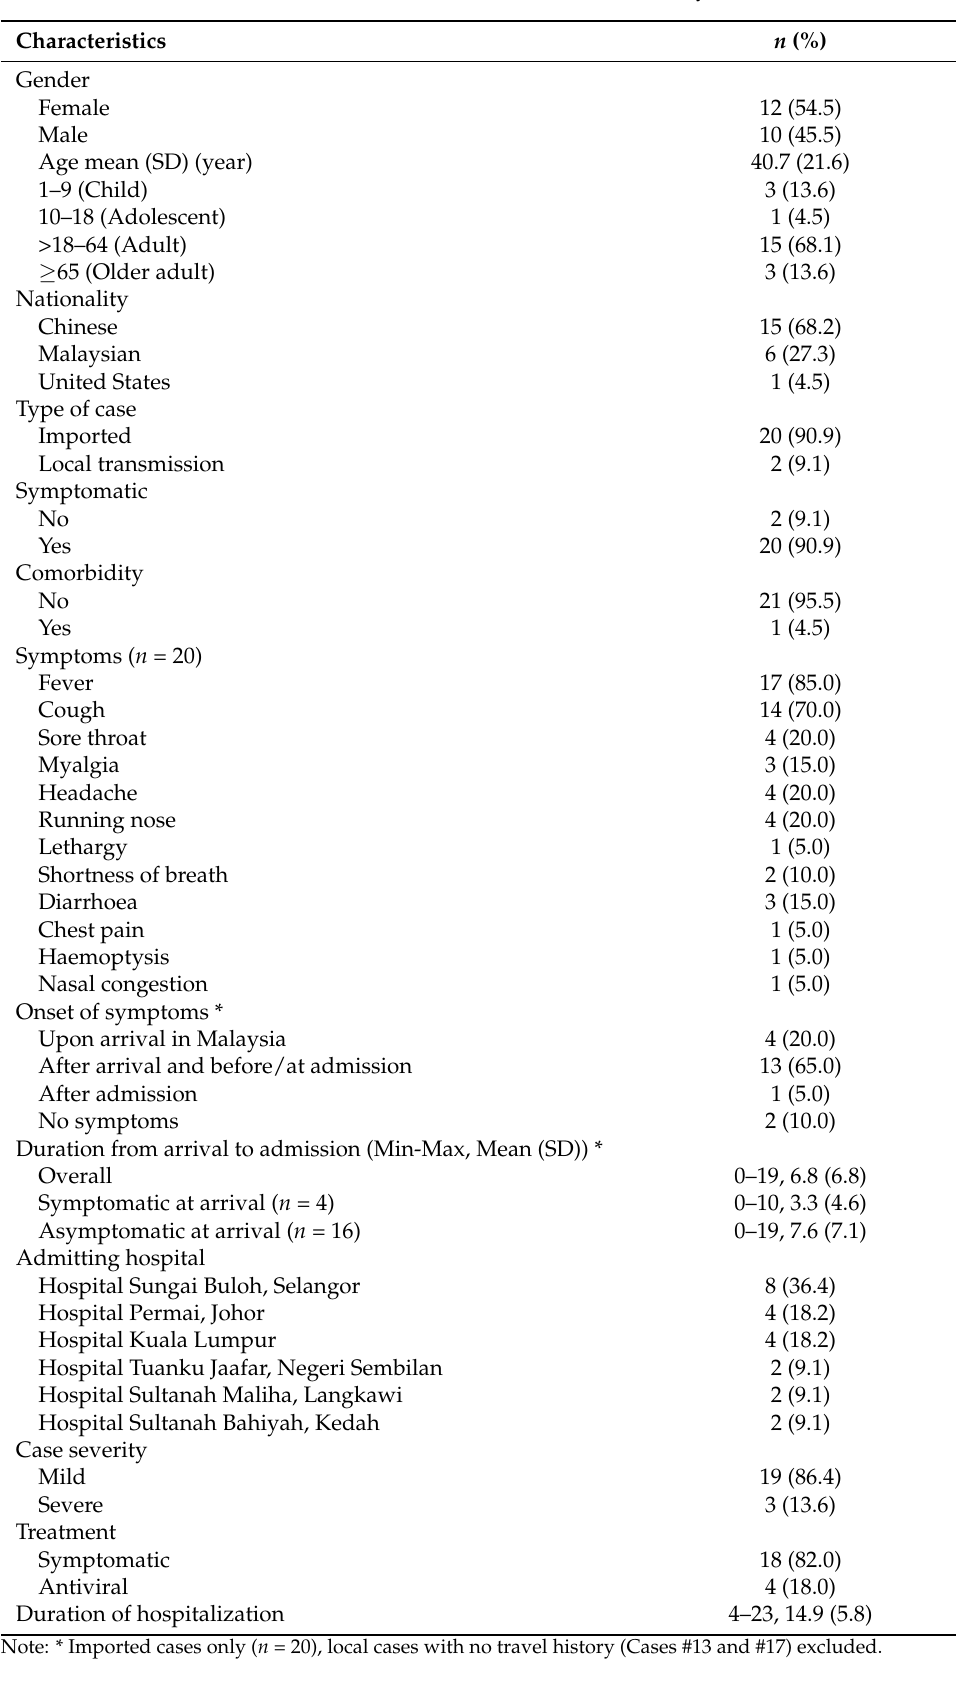
Table 2. Characteristics of the first wave of cases of COVID-19 in Malaysia.